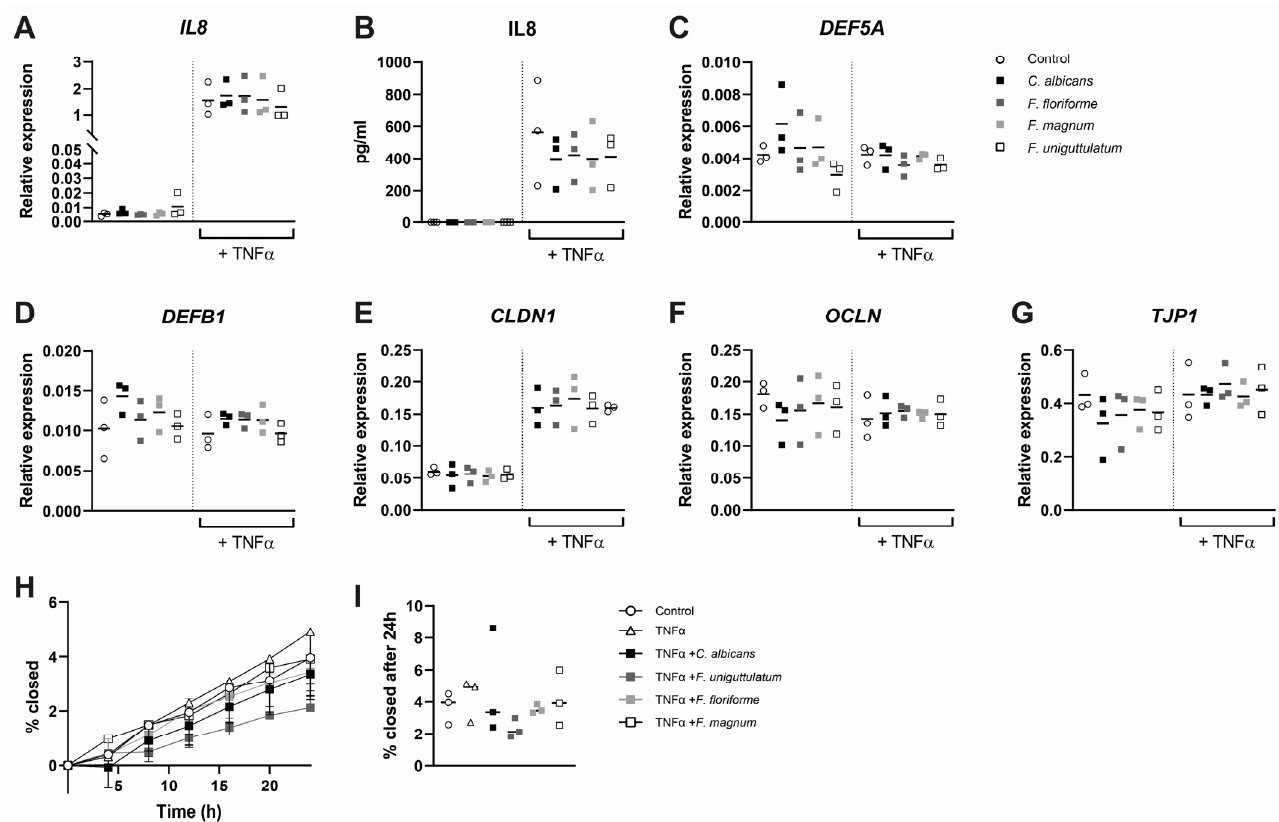
Figure 4. Stimulation of epithelial cells to Filobasidium species results in no pro-inflammatory response. ( A , C – G ) Relative expression of IL8 , DEF5A , DEFB1 , CLDN1 , OCLN , and TJP1 upon stimulation of HT29 epithelial cells with yeast for 4 h ( n = 3). Expression normalized against references genes HPRT and GAPDH. ( B ) Supernatant IL8 concentrations after 24 h stimulation of HT29 monolayers. ( H ) Epithelial wound healing assay with simultaneous stimulation with yeast species. Closure is expressed as percentage of scratch area closed at 4 h intervals for 24 h. ( I ) Wound closure after 24 h of incubation with yeast. Data are presented as median and separate data points and were tested using Kruskal–Wallis